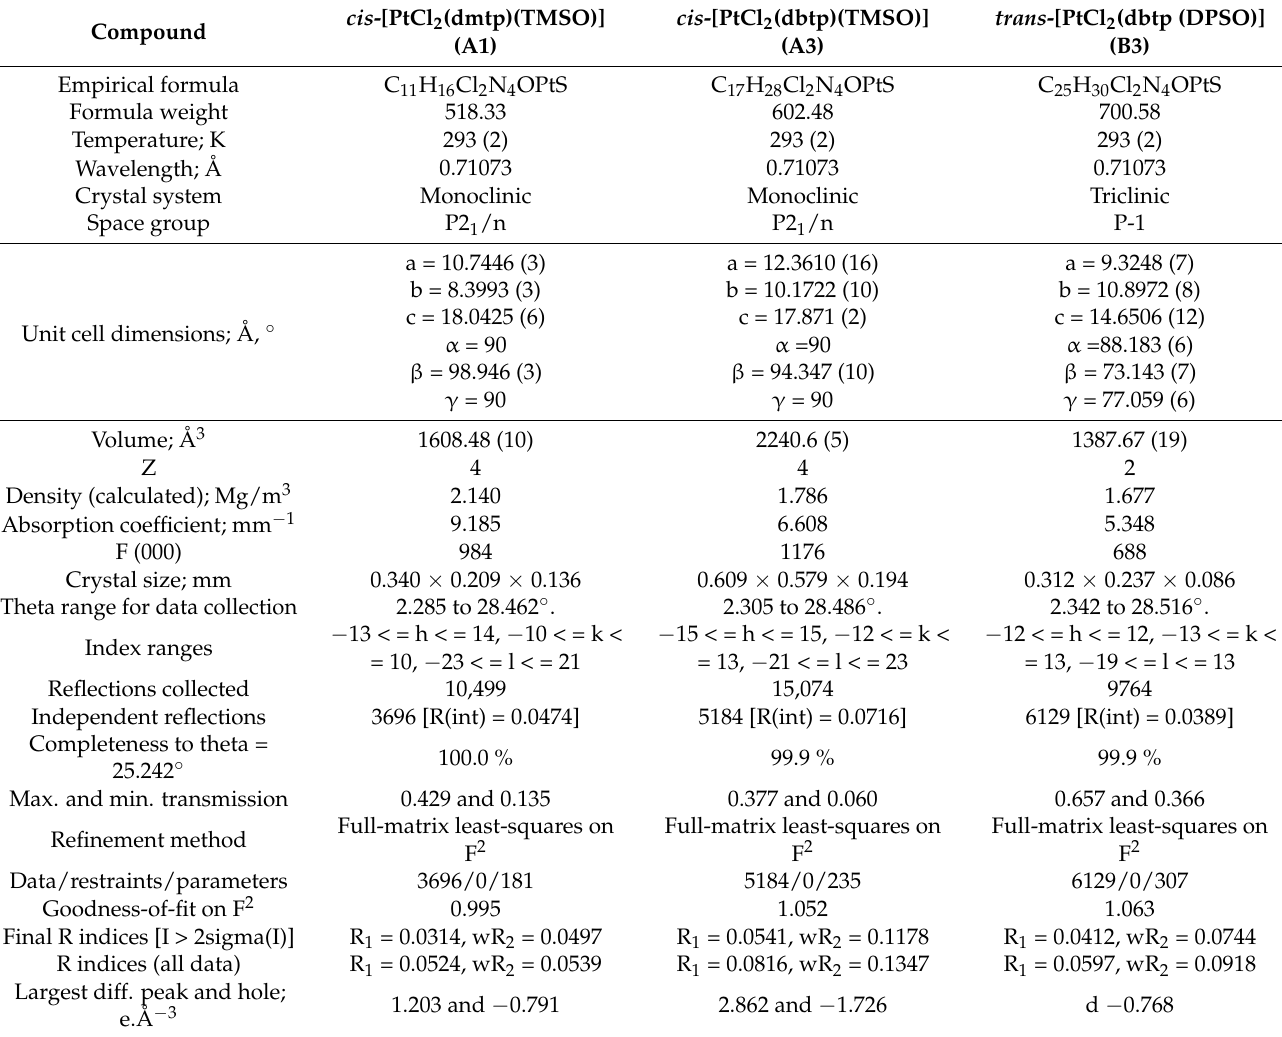
Table 5. Crystal data and structure refinement for ( A1 , A3 and B3